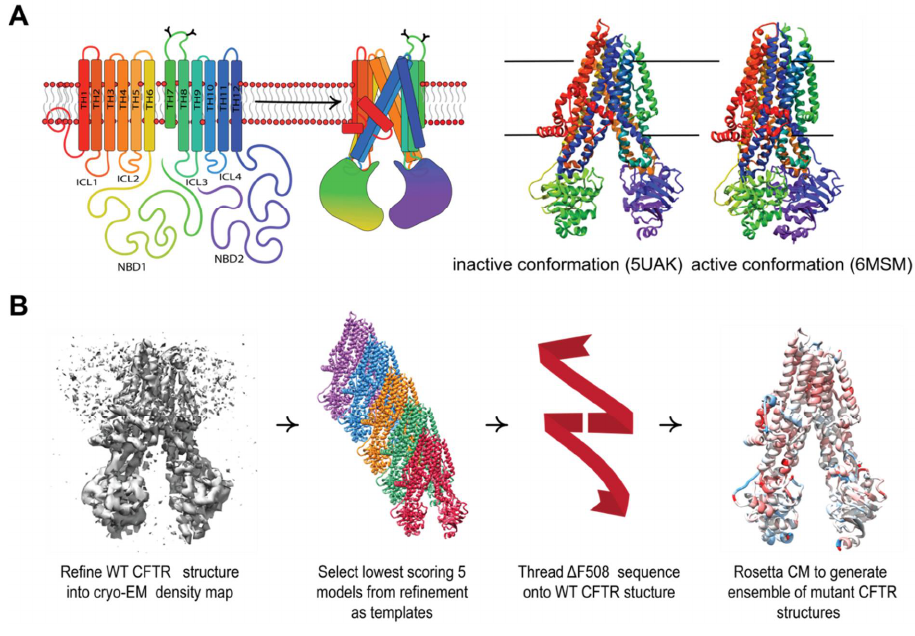
Figure 1. Comparative modeling captures multi-domain CFTR thermodynamics. ( A ) The complex topology of CFTR involves interdomain contacts formed during the folding process that include intercellular loops (ICLs) interfacing with the cytosolic NDBs. The inactive PBD ID 5UAK [2] (left) and active PBD ID 6MSM [6] (right). ( B ) Our workflow for generating ensembles of F508del models in this study (see Methods).